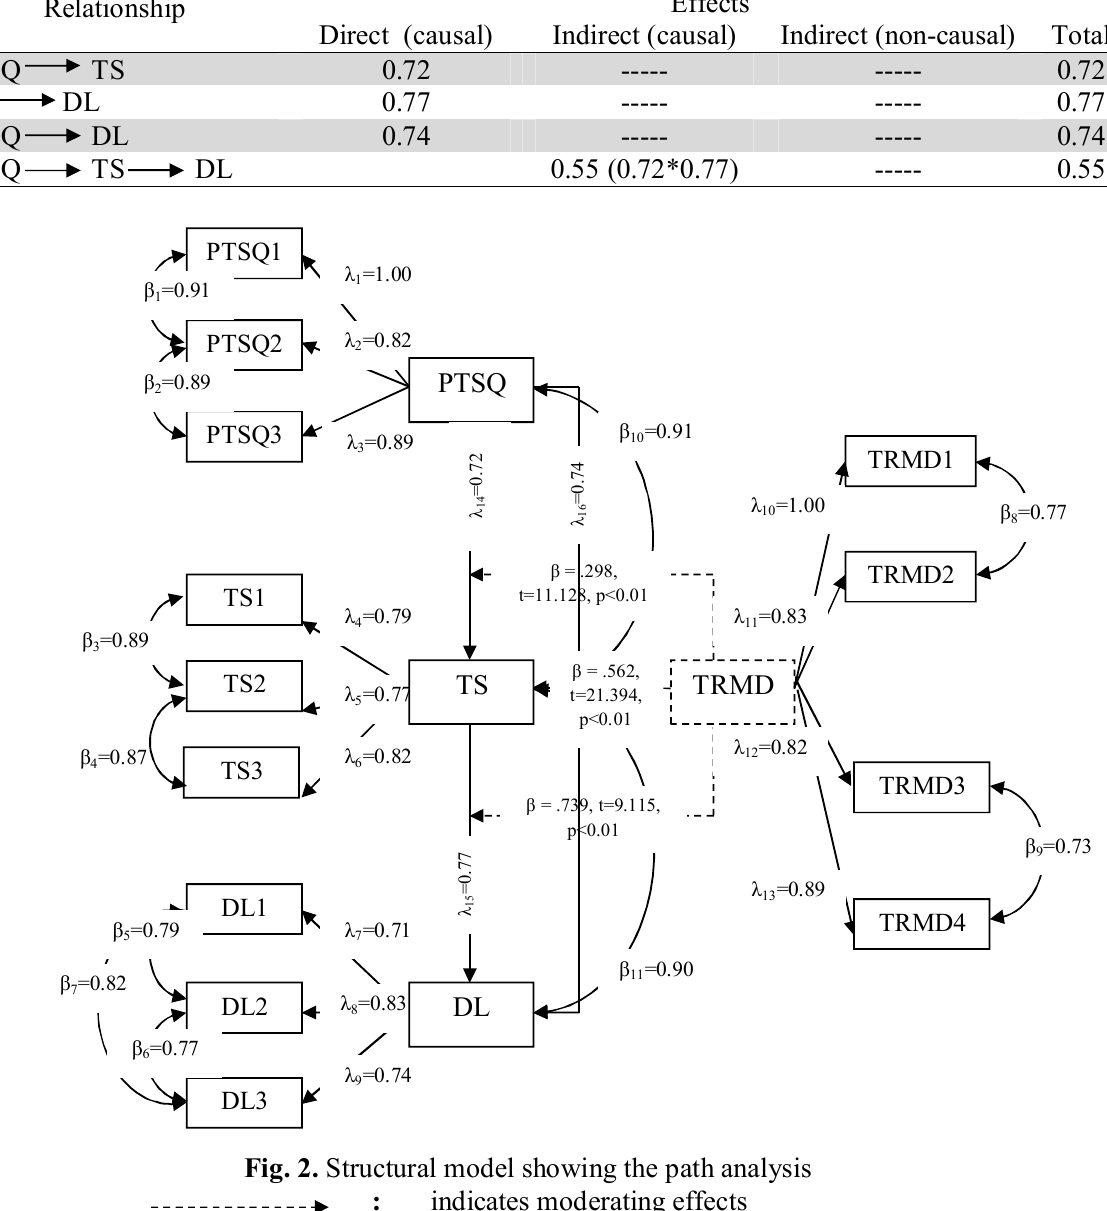
Fig. 2. Structural model showing the path analysis : indicates moderating